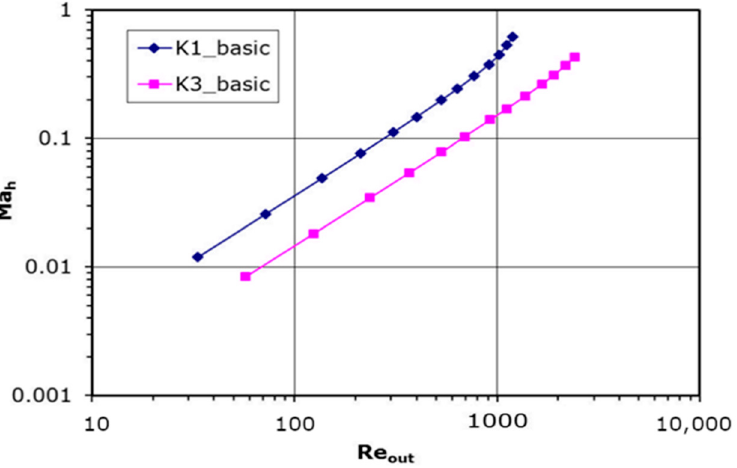
Figure 5. Mach number versus Reynolds number plot.